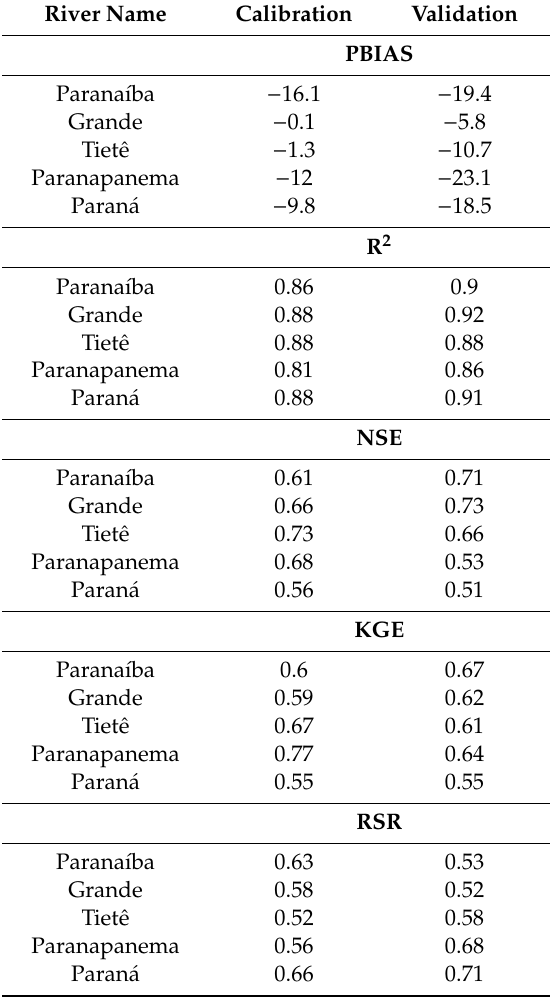
Table 3. Objective function values from the final outlets of the main rivers for the calibration (1984–2004) and validation (2005–2015)